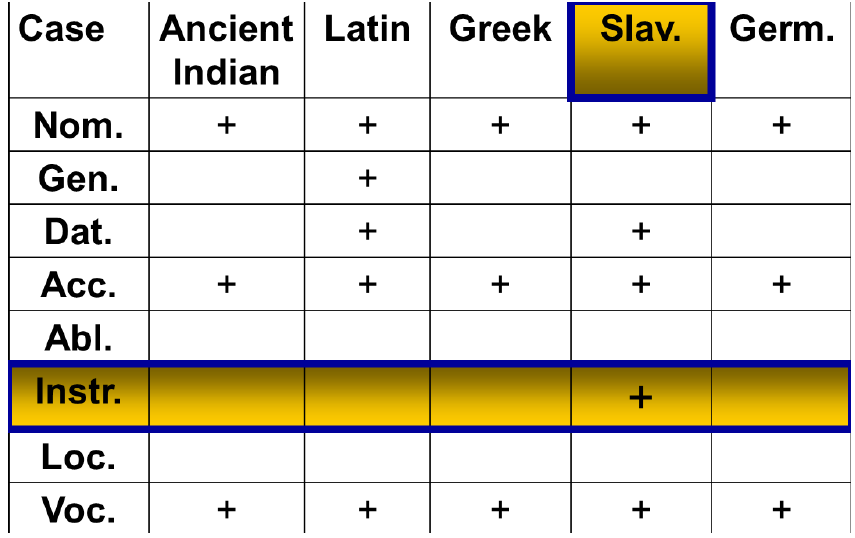
Figure 2 - Preservation of pure case meanings in Indo-European languages (according to B. Delbrück 1867) DOI: